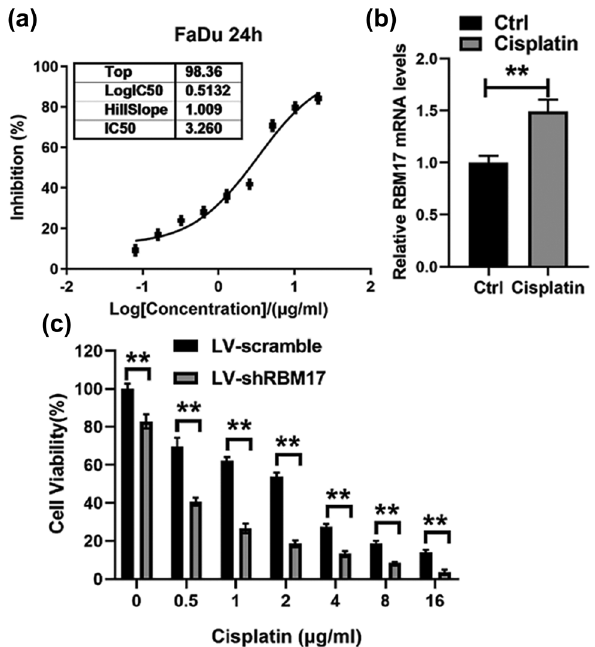
Figure 2: Downregulation of RBM17 enhances cisplatin sensitivity in vitro . ( a ) Inhibition of cisplatin on FaDu cells was in a concentration - dependent manner ( b ) FaDu cells were treated with 3.26 μ g/ml cisplatin for 24 h, and the mRNA level of RBM17 was detected by real - time PCR. ( c ) LV - shRBM17 - or LV - scramble - infected cells were incubated with di ff erent concentrations of cisplatin for 24 h, and the cell viability was determined by CCK - 8 assays. ** P <